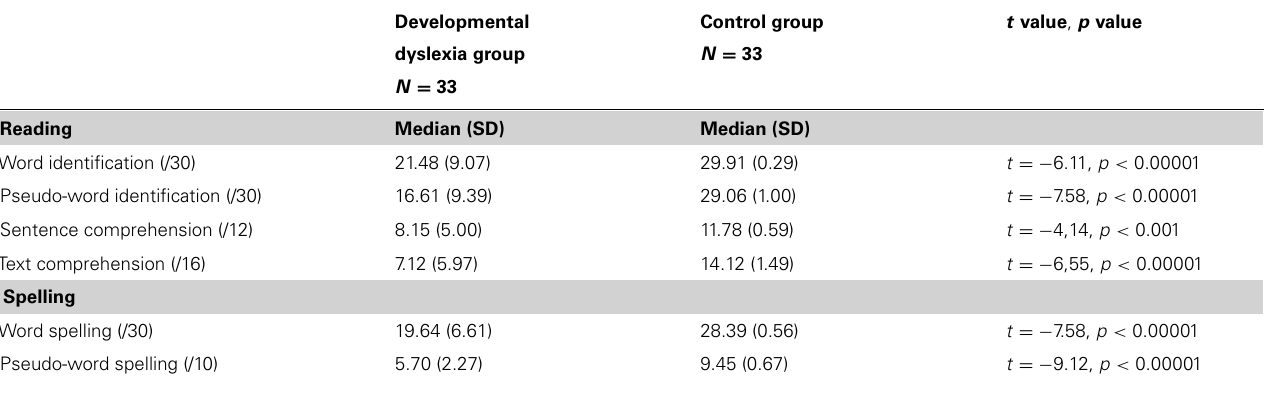
Table 1 | Performance of the participants, median (standard-deviation) on the screening tests of reading and